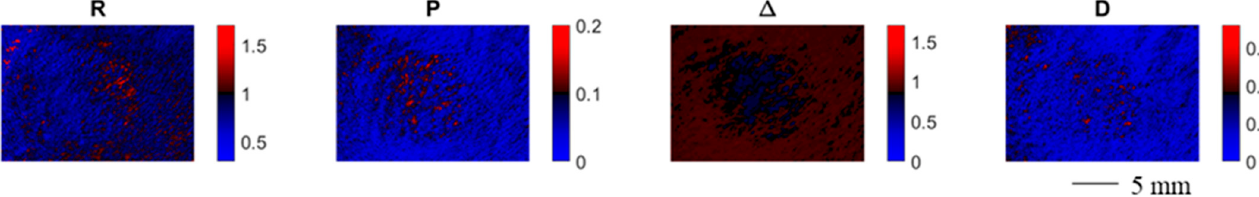
Figure 5. Spatially resolved polarimetric parameters for an exemplary hypertrophic scar. Each po ‐ larimetric parameter provides a certain degree of contrast between the scarred and the healthy skin area. The range adjusted polarization stain images are displayed in Figure 6 for a contrac ‐ ture scar (left) and a hypertrophic scar (right). The scarred areas are easily distinguished from the healthy skin. However, the values shift toward the edges of the image. The rea ‐ son for this might be the curved skin geometry. Figure 6. Range adjusted polarization stain image for a contracture scar ( left ) and a hypertrophic scar ( right ). The scarred areas are clearly distinguishable. The values shift toward the edges of the image and the curved skin geometry may be the cause of this. Figure 7 displays the threshold polarization stain images for a contracture scar (left) and a hypertrophic scar (right). The scarred skin can easily be identified. Near the margins of the image, the values change as for the range adjusted PSI. Again, the curved skin ge ‐ ometry could be the cause of this as the degree of polarization can be affected by the sur ‐ face normal [36] and therefore also the surface roughness [37,38] of the skin. Therefore, results from complex skin topographies and roughness might be difficult to interpret. Ad ‐ ditionally, the signal ‐ to ‐ noise ratio could increase near the edges of the field of view in the case of non ‐ uniform illumination [39].